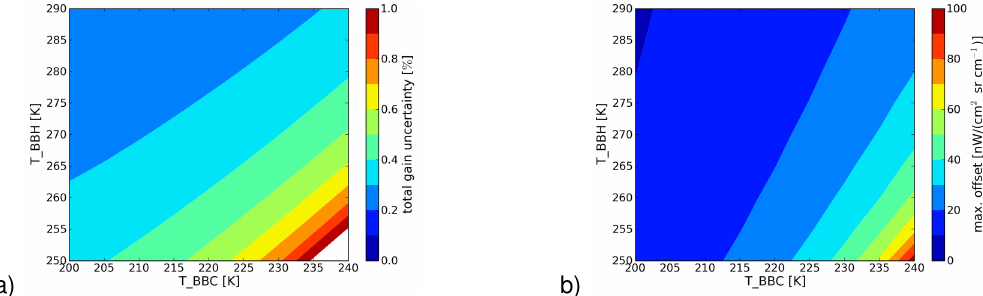
Fig. 9. Radiance uncertainty as a function of GBB-C and GBB-H temperatures: (a) total gain uncertainty and (b) maximum offset uncertainty.